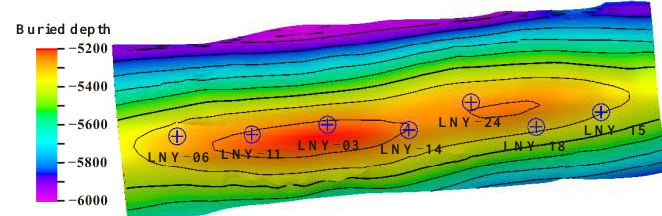
Figure 6. Schematic diagram of the top of layer K 1 BS 1 .